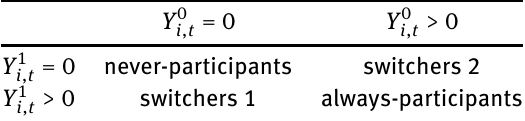
Table 1: Subgroups Based on the Joint Distribution of Potential Outcomes in Period t